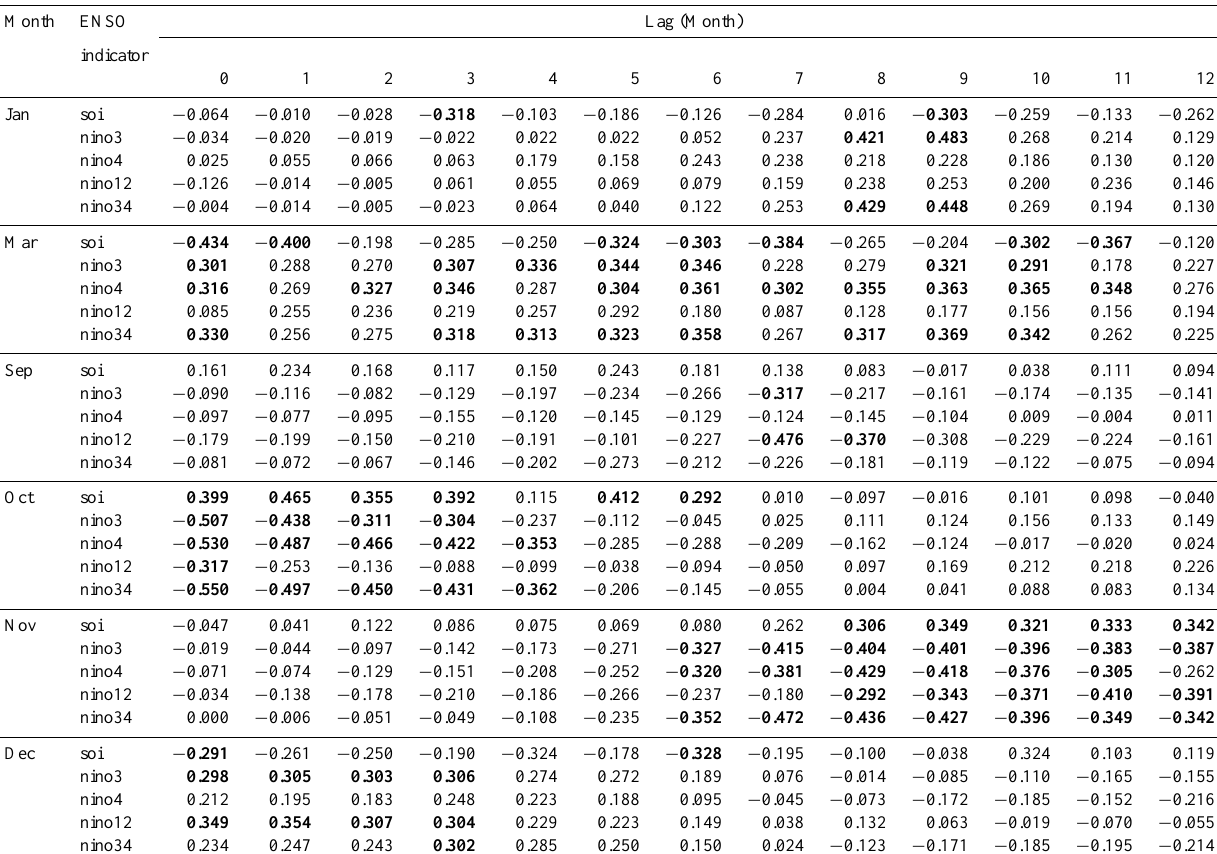
Table 2. The correlations between monthly precipitation and monthly ENSO indicators with different lag month. Month ENSO Lag (Month)